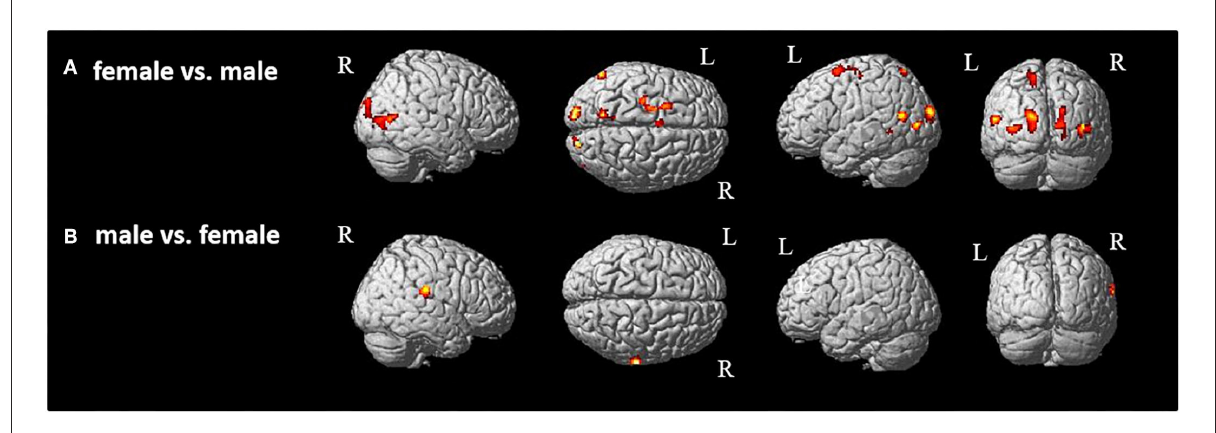
FIGURE3 Group comparison between (A) female and (B) male participants [p < 0.05 (FWE), k = 0]. R, right hemisphere; L, left